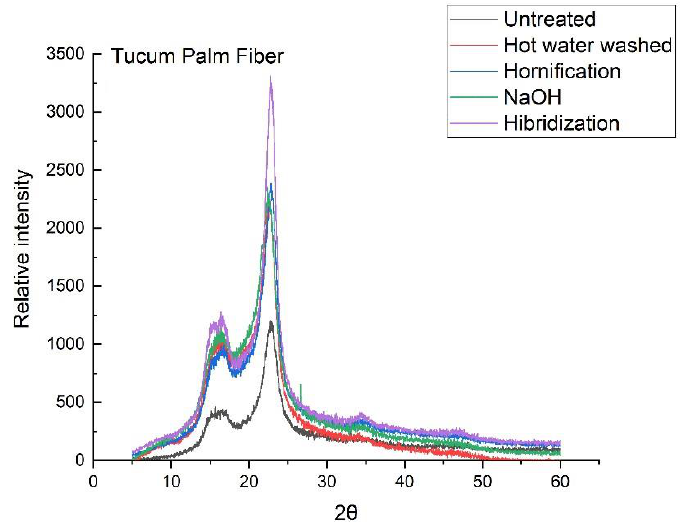
Figure 4. X-ray diffractograms of the untreated and treated fibers of the tucum palm. Different conditions: untreated (black), hot water washed (red), hornification treatment (blue), NaOH (green), and hybridization (purple).